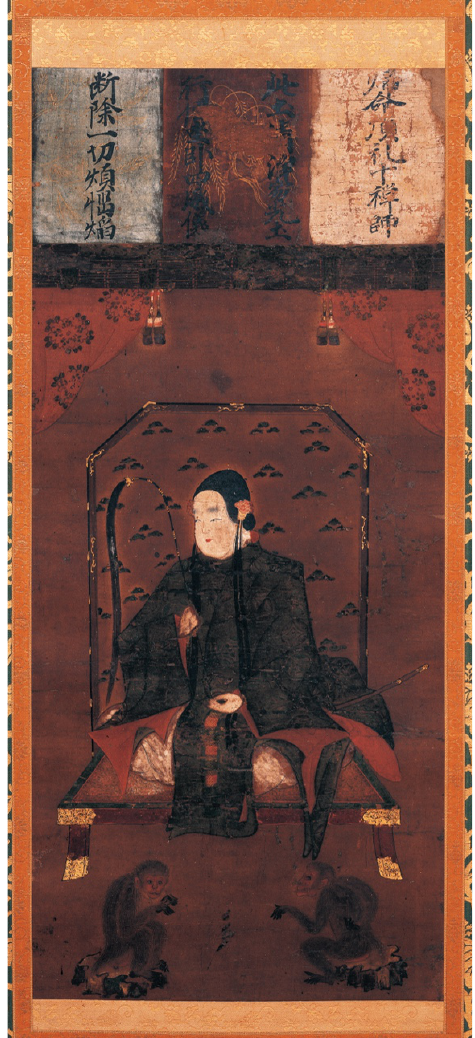
Figure 1. Jūzenji as a child , fifteenth century, hanging scroll, color on silk. Kokuhōden, Enryakuji, Figure 1. J¯uzenji as a child , fifteenth century, hanging scroll, color on silk. Kokuh¯oden, Enryakuji, Shiga prefecture. Shiga